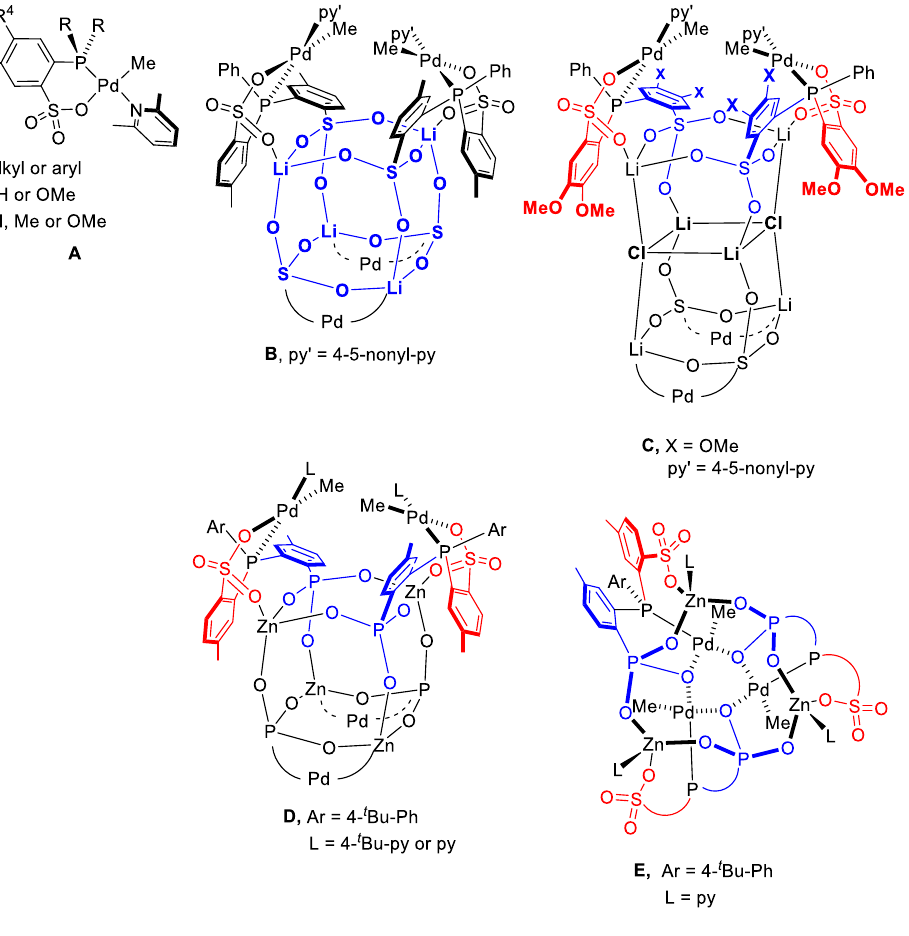
Figure 1. (PO)PdR Complexes. Py’ = 4-(5-nonyl)pyridine. The lower (Li-OPO)PdMe(py’) or (OP-P- SO)PdMeL units in the schematic structure of B , C , and D are denoted by